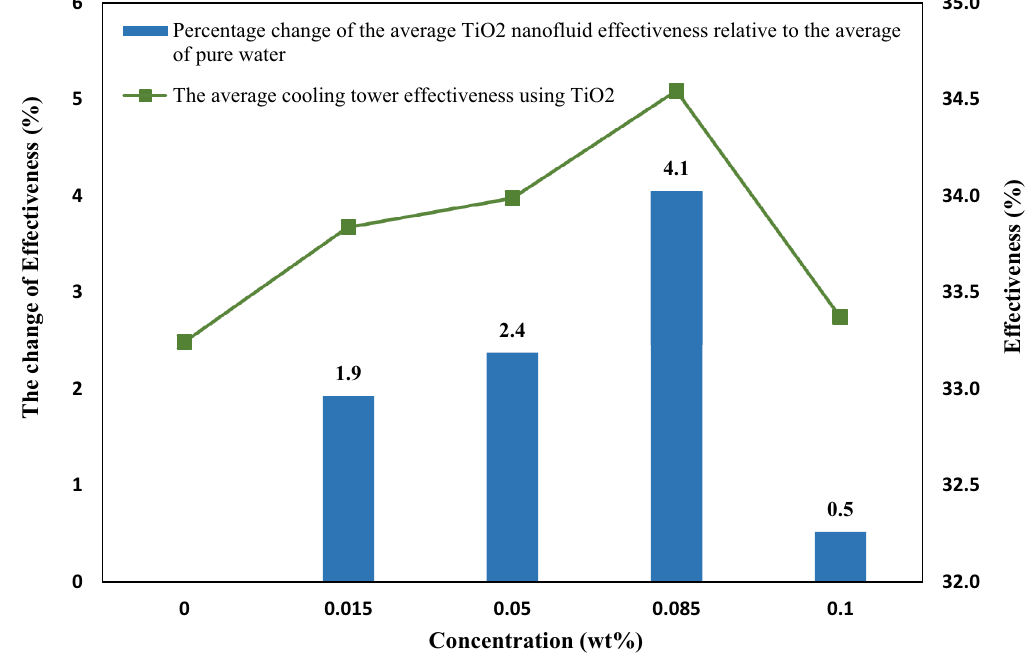
Figure 13. The average effectiveness and the percentage variation in the average effectiveness at specific concentrations in all the flow rates using nanofluids compared to pure water. Source Sum of squares df Mean square F-value p